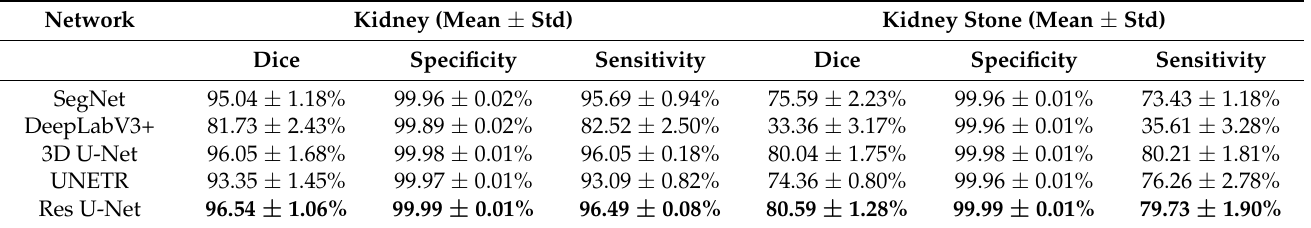
Table 1. The performances of the networks trained ten times with the proposed training scheme.